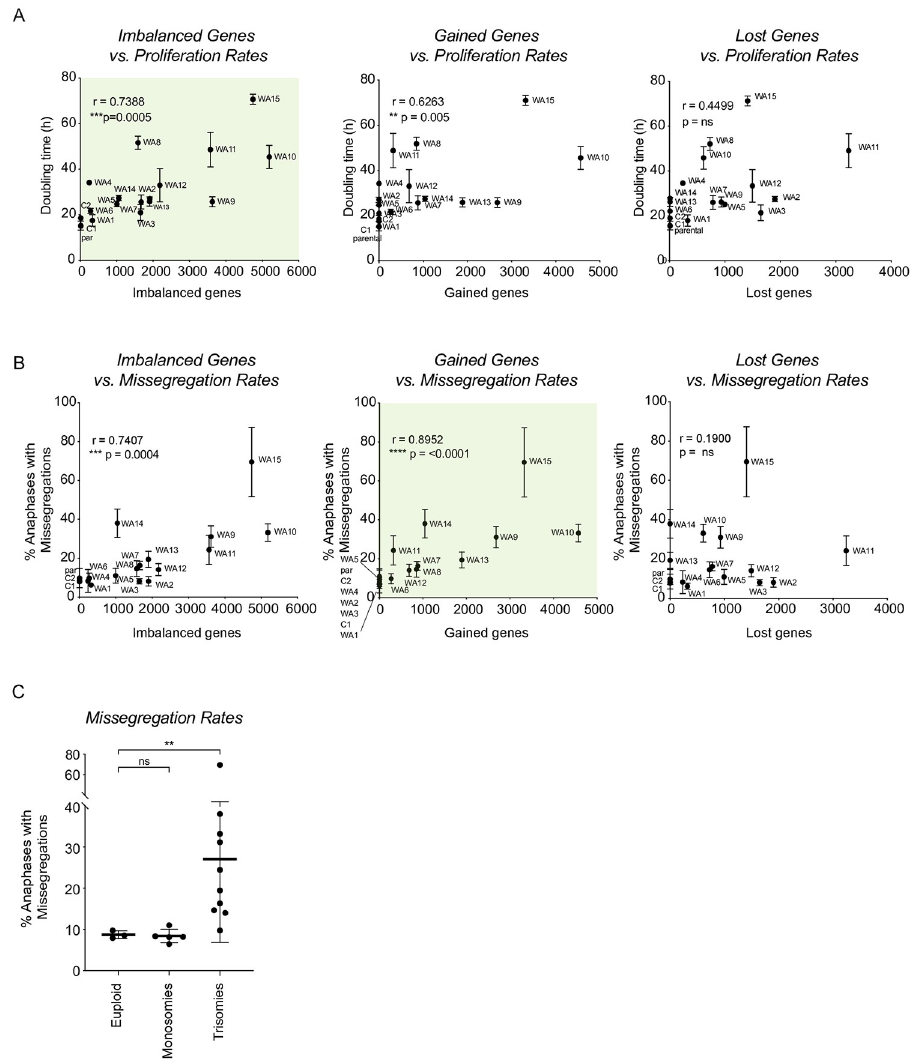
Fig 2. Both monosomies and trisomies decrease cellular fitness. A. Spearman correlation between the total number of imbalanced, gained and lost coding genes per clone and proliferation rates as measured in Fig 1A. Error bars indicate standard deviation. Light green panels indicate the preferred model. B. Spearman correlation between the number of imbalanced, gained and lost coding genes and the level of CIN as percentage of total number of anaphases as determined in Fig 1B. Error bars indicate standard deviation. Light green panels indicate the preferred model. C. Missegregation rates described in A, classified in three different categories: euploid clones, clones harboring only monosomies and clones harboring trisomies (sometimes with monosomies in the background). Lines show the mean; error bars indicate standard deviation. The Mann-Whitney U statistical test was used to compare differences in CIN between